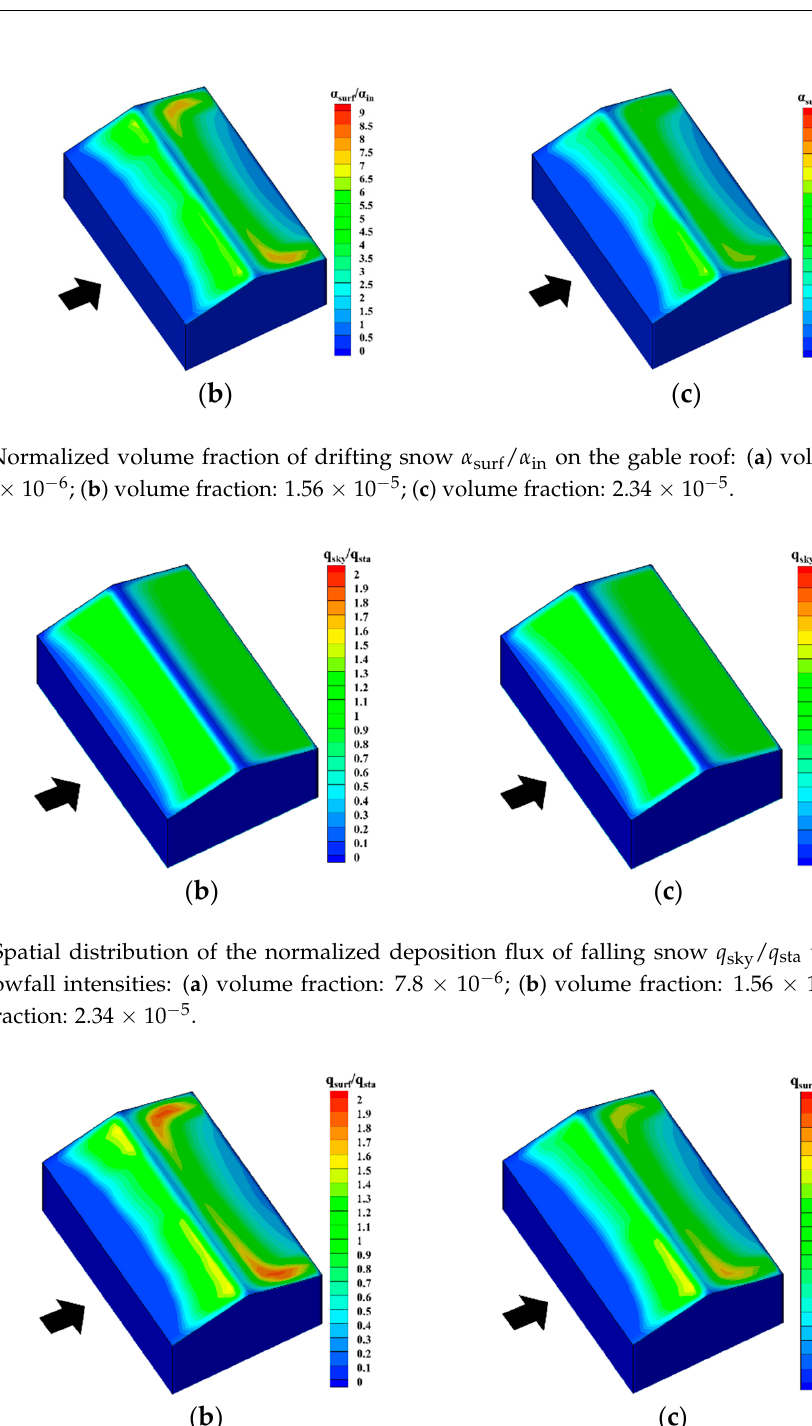
Figure 21. Spatial distribution of the normalized deposition flux of falling snow q sky / q sta with dif- ferent snowfall intensities: ( a ) volume fraction: 7.8 × 10 − 6 ; ( b ) volume fraction: 1.56 × 10 − 5 ; ( c ) volume fraction: 2.34 × 10 − 5 . Figure 22. Spatial distribution of the normalized deposition flux of drifting snow q surf / q sta with dif- ferent snowfall intensities: ( a ) volume fraction: 7.8 × 10 − 6 ; ( b ) volume fraction: 1.56 × 10 − 5 ; ( c ) volume fraction: 2.34 × 10 − 5 .